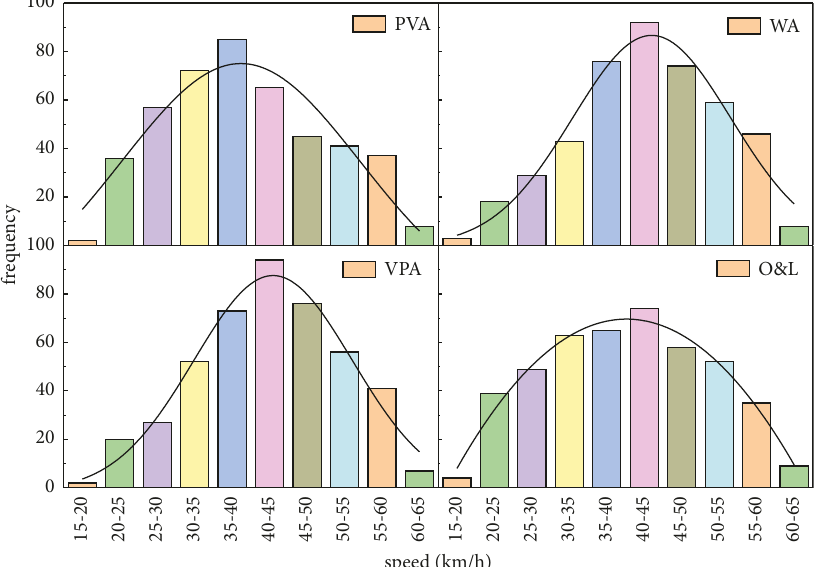
Figure 9: Distribution of speed at different types of random risk points.